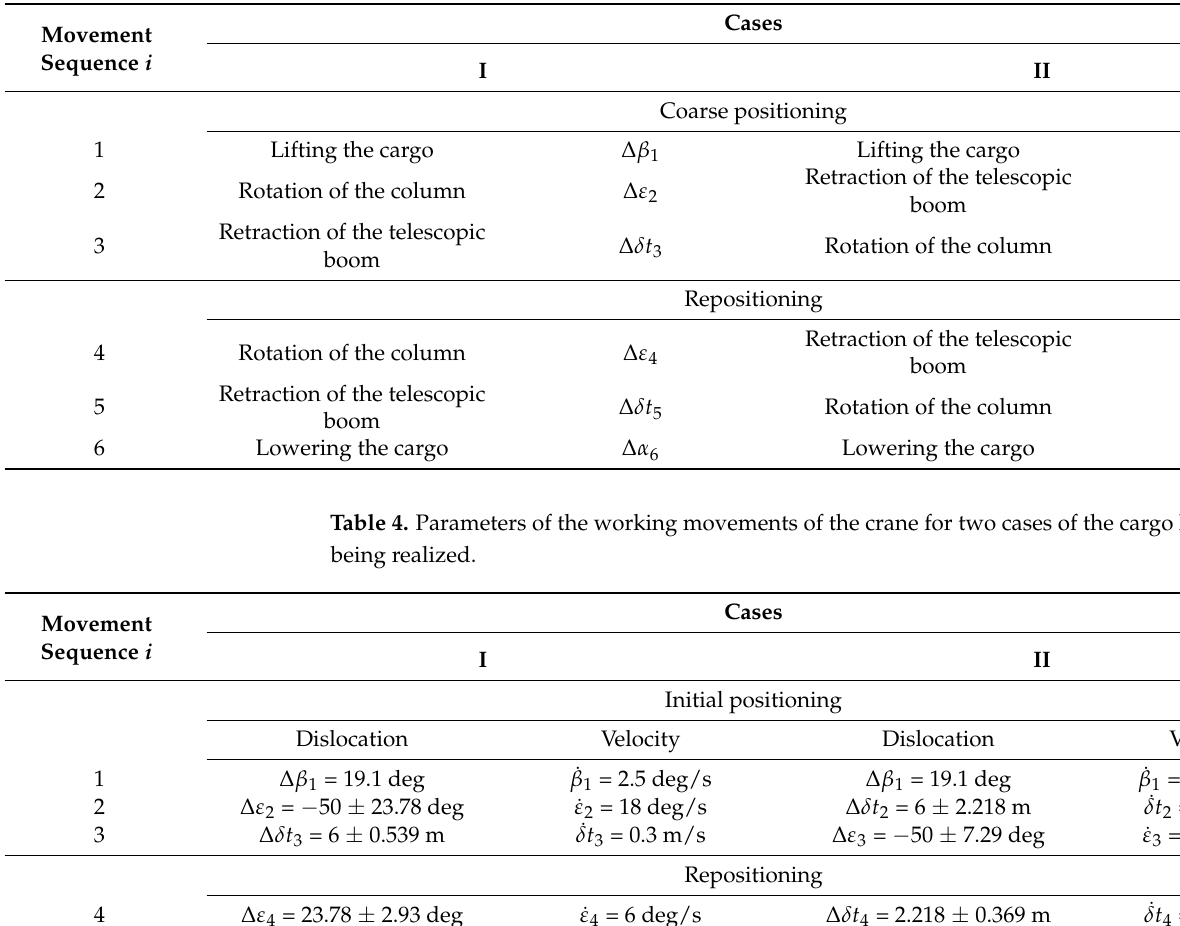
Table 3. Sequences of the working movements of the crane, for two cases of the realized cargo handling task.